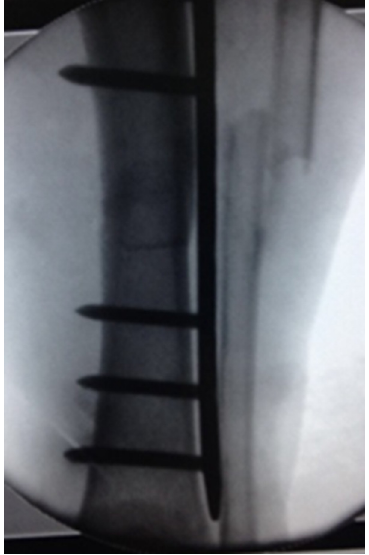
Figure 4. Distal end of the plate fi xed to the distal